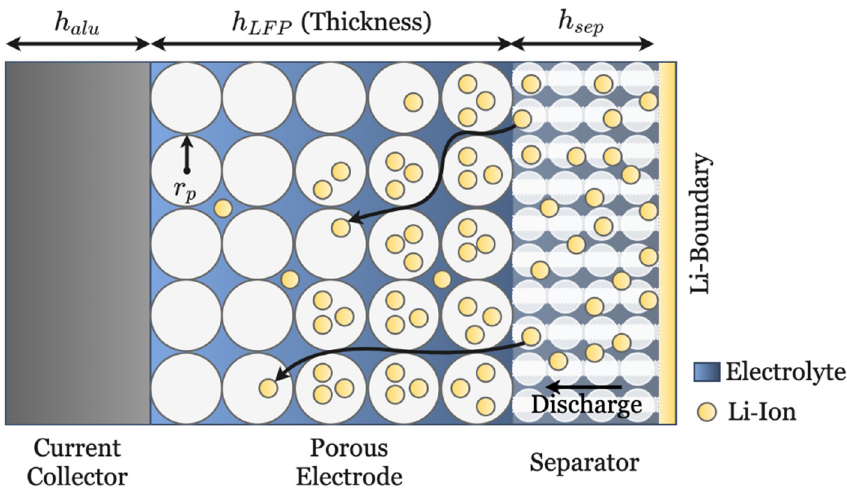
Figure 1. Schematic view of the electrochemical cell consisting of a porous LFP electrode and an ideal lithium electrode separated by an electrolyte zone and a separator. The figure shows the lithium diffusion through the cell and the lithiation of the LFP electrode during discharge.